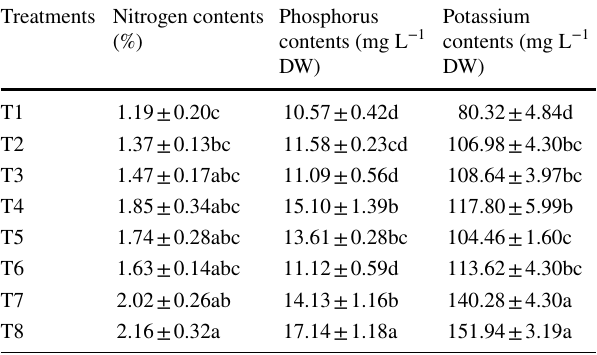
Table 5 Effect of different growing media on NPK contents of